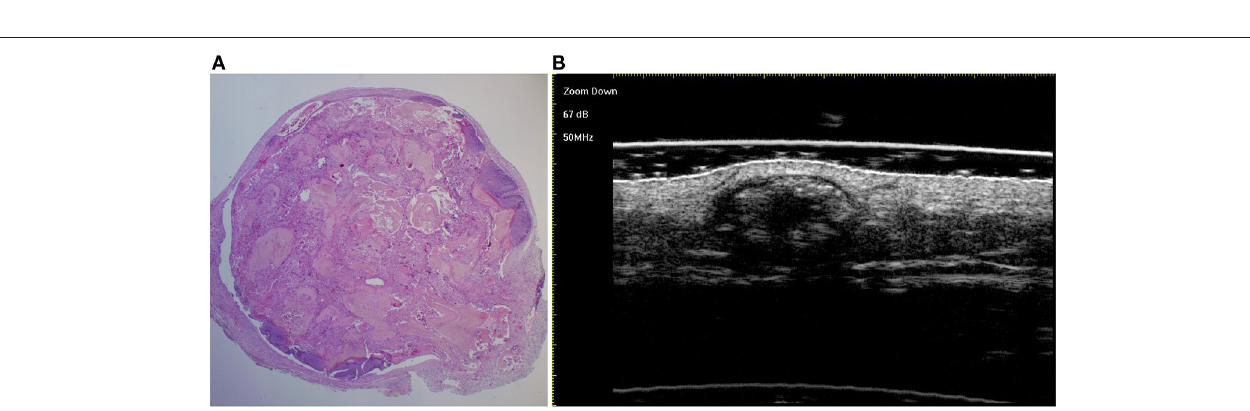
FIGURE 3 | The histological presentation [ (A) HE, original magnification × 10] and ultra-high frequency ultrasound (B) of PM in the early stage, indicating no obvious calcification and cystic formation.